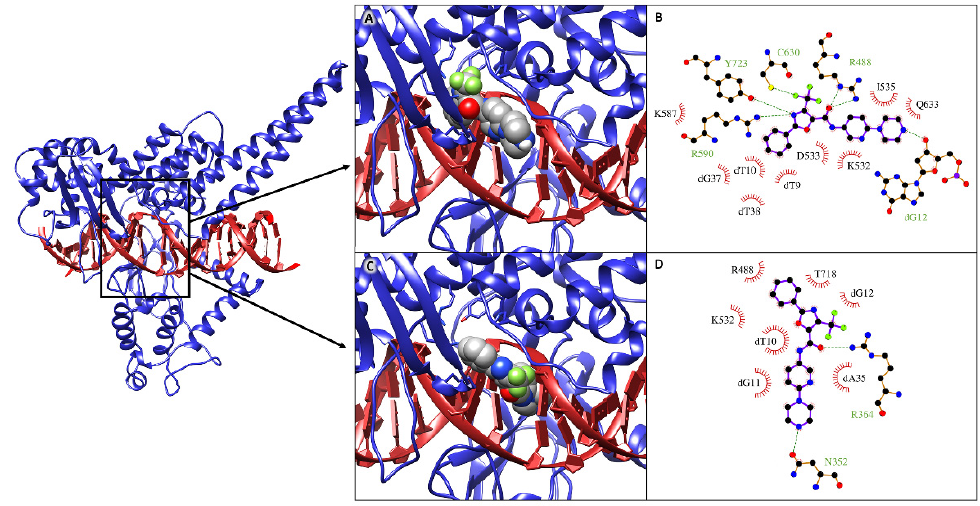
Figure 5. On the left: 3D structure of the htopIB-DNA complex (PDBID: 1T8I), used as receptor for the molecular docking simulations. The binding site is highlighted by a rectangular box. The htopIB structure is represented as a blue cartoon, while the DNA is shown as a red ribbon. ( A , C ) 3D best binding poses obtained for the drug MMV024937 in “non intercalated” ( A ) and “intercalated” ( C ) configuration. The MMV024937 compound is shown in a space fill model, colored by atom type, with carbon atoms in grey, while htopIB catalytic residues are shown as stick models, colored by atom type, with carbon atoms in blue. The pictures were obtained using the Chimera program [28]). ( B , D ) 2D schematic view of the interactions between the drug and the htopIB-DNA complex in “non intercalated” ( B ) and “intercalated” ( D ) configuration. Hydrogen bonds between the drug molecule and the interacting residue/base are shown as dashed lines. Hydrophobic interactions are shown as radial half-circles. Labels indicate base or residue names in one-letter code and their numbering in the structure. The pictures were created using the LigPlot+ 1.4 software [29].